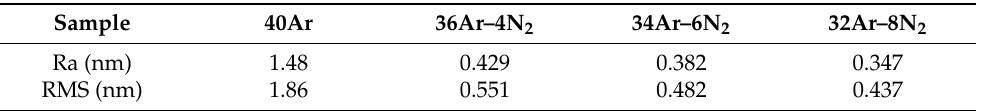
Table 1. The average surface roughness of Ta 2 O 5 coatings prepared under different sputtering gas conditions was measured by AFM.